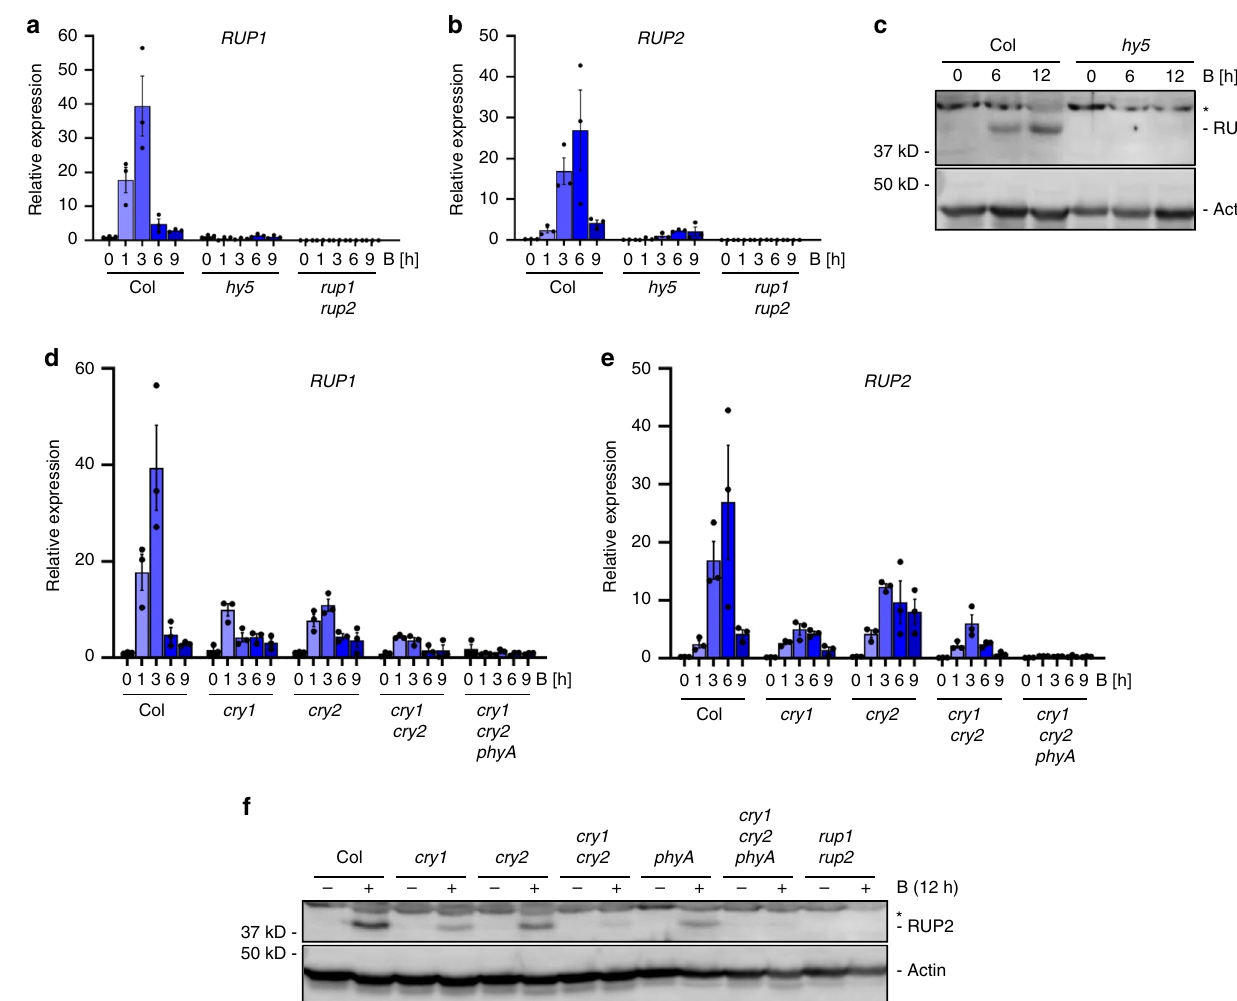
Fig. 1 Blue-light-induced RUP1 and RUP2 expression and RUP2 protein accumulation depend on cry1, cry2, phyA, and HY5. a , b qRT-PCR analysis of a RUP1 and b RUP2 expression in 4-d-old wild type (Col), hy5-215 ( hy5 ), and rup1-1 rup2-1 ( rup1 rup2 ) seedlings grown in darkness or treated with blue light (B; 50 µ mol m − 2 s − 1 ) for 1, 3, 6, or 9 h. Data are means ± SEM ( N = 3). c Immunoblot analysis of RUP2 protein level in 4-d-old Col and hy5 seedlings grown in darkness (0) or treated with blue light for 6 or 12 h. The asterisk indicates a nonspeci fi c cross-reacting band. Actin is shown as protein loading control. d , e qRT-PCR analysis of d RUP1 and e RUP2 expression in 4-d-old Col, cry1-304 ( cry1 ), cry2-1 ( cry2 ), cry1-304 cry2-1 ( cry1 cry2 ), and cry1-304 cry2-1 phyA-412 ( cry1 cry2 phyA ) seedlings grown in darkness or treated with blue light for 1, 3, 6, or 9 h. Data are means ± SEM ( N = 3). Note that the Col samples in panels ( d ) and ( e ) are identical to those in panels ( a ) and ( b ), respectively, as the data are derived from the same experiment. f Immunoblot analysis of RUP2 protein level in 4-d-old Col, cry1 , cry2 , cry1 cry2 , phyA-211 ( phyA ), cry1 cry2 phyA , and rup1 rup2 seedlings grown in darkness, then treated with blue light for 12 h ( + ) or not ( − ). The asterisk indicates a nonspeci fi c cross-reacting band. Actin is shown as protein loading